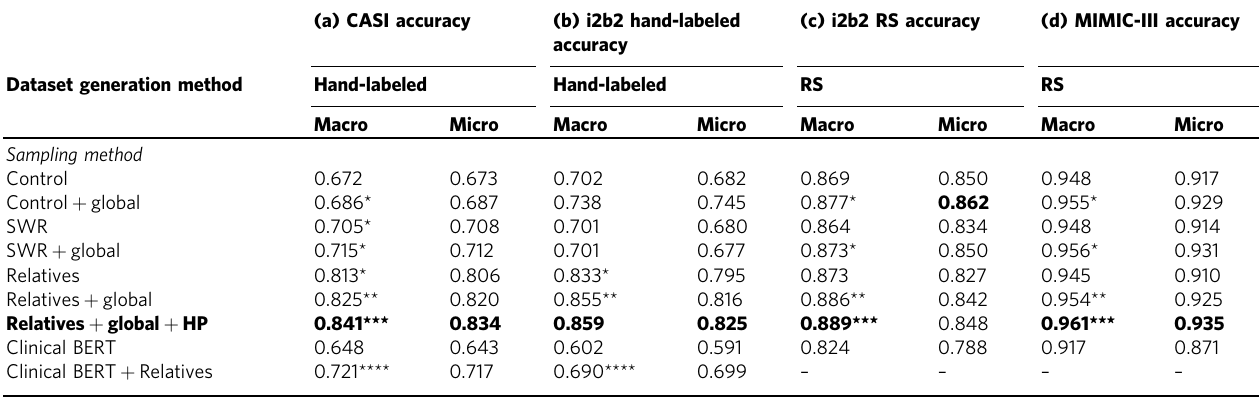
Table 1 Micro and macro accuracy of (%) of our model on (a) CASI abbreviations, (b) i2b2 generated by hand labeling, (c) i2b2 generated by RS, and (d) MIMIC III generated by